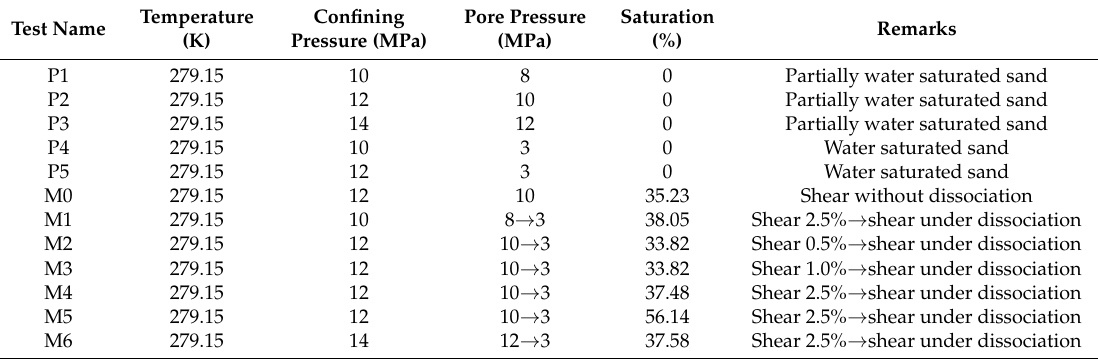
Table 1. Experimental parameters and shear